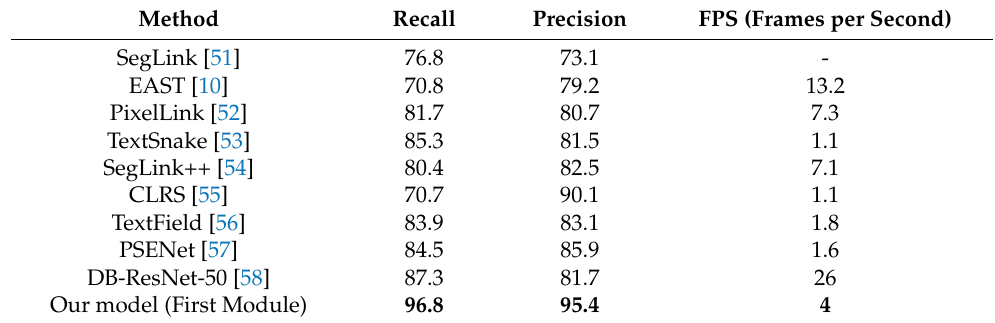
Table 1. The test results of a comprehensive benchmarking of our model (for text detection) against selected state-of-the-art models.